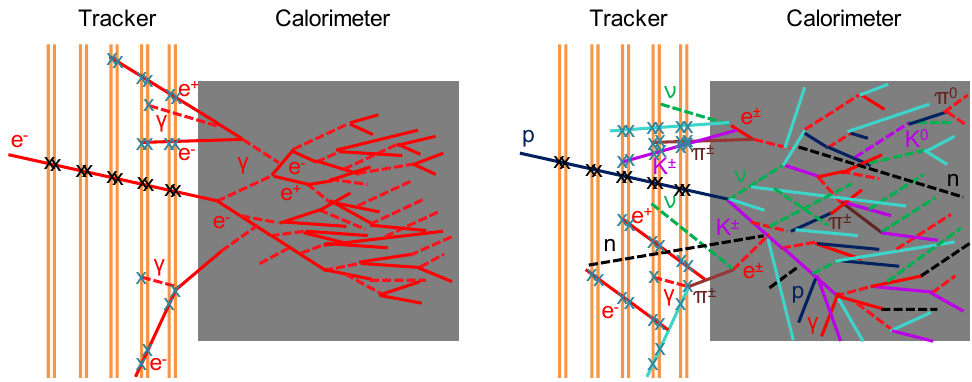
Figure 1. Representation of the secondary particle tracks in a tracking detector upstream of a calorimeter. Primary electrons ( left ) generate an electromagnetic shower in the calorimeter which may feature only ultra-relativistic e ± and γ backsplash secondaries in the upstream detectors. Interacting primary protons and nuclei ( right ) generate an hadronic shower (here sketched for display purpose only) in the calorimeter, which may feature a component of slow backsplash secondaries in the upstream